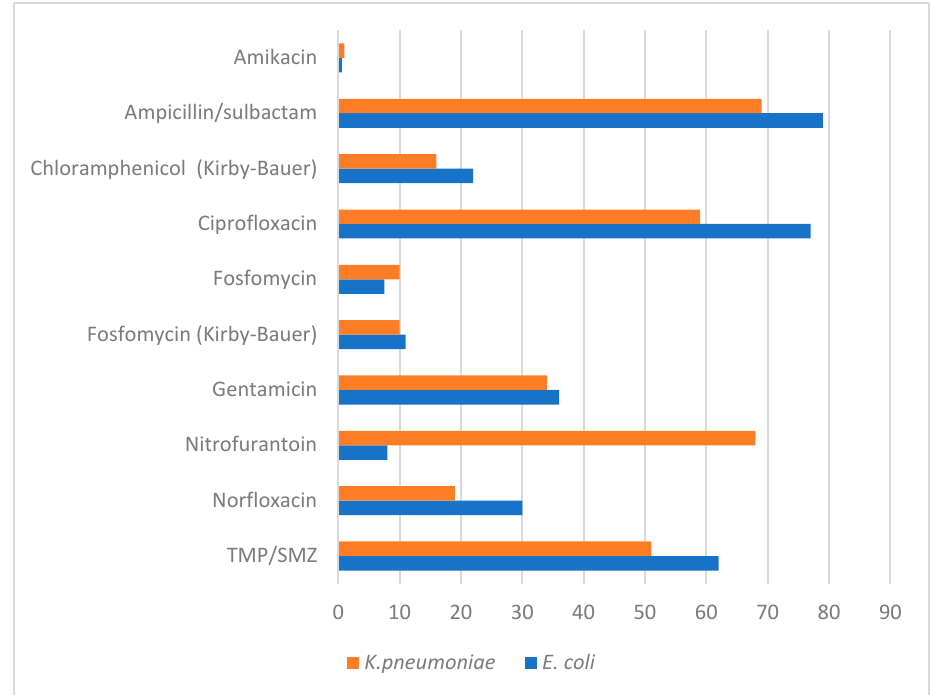
Figure 1. Antibiotic resistance percentages in Escherichia coli ( n = 156) and Klebsiella pneumoniae ( n = 82) isolates from urine cultures.